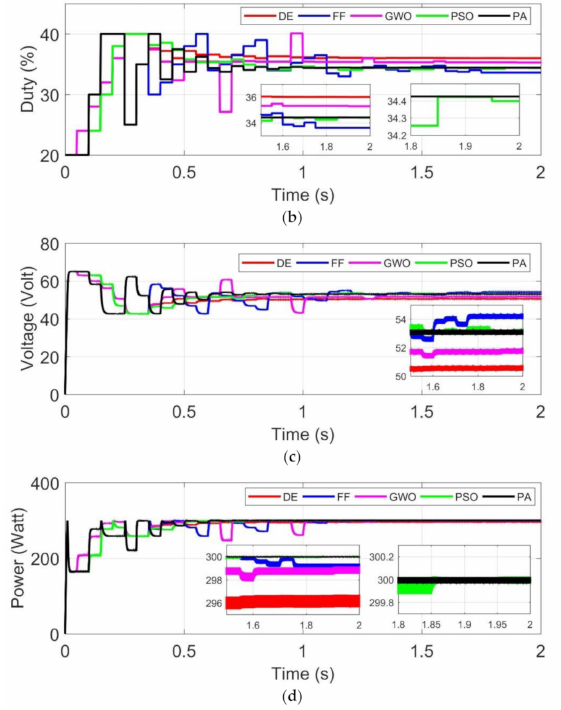
Figure 11. Test 3 ( a ) Initial particles ( b ) Duty cycle (%) ( c ) PV voltage (V) ( d ) PV power (W).